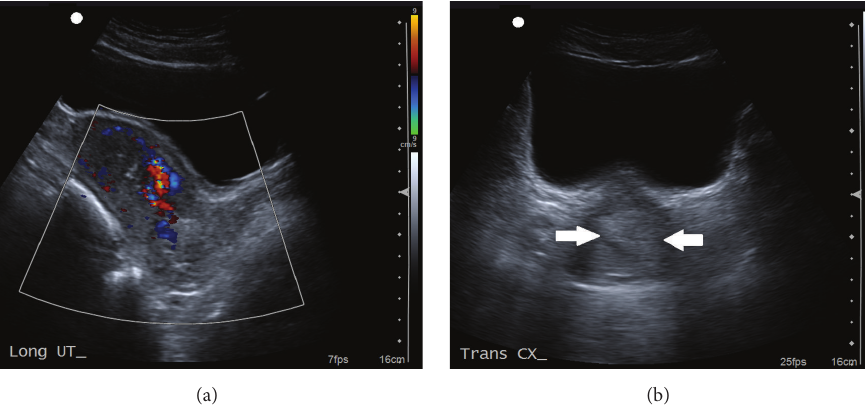
Figure2:(a) TASag Uterus, Color .Transabdominaluterusshowingbloodflowwithintheechogenicintraendometrialtissue,makingretained products highly likely. (b) TA Trans Uterus . Transabdominal transverse view of the uterus showing echogenic material within the lower endometrial cavity